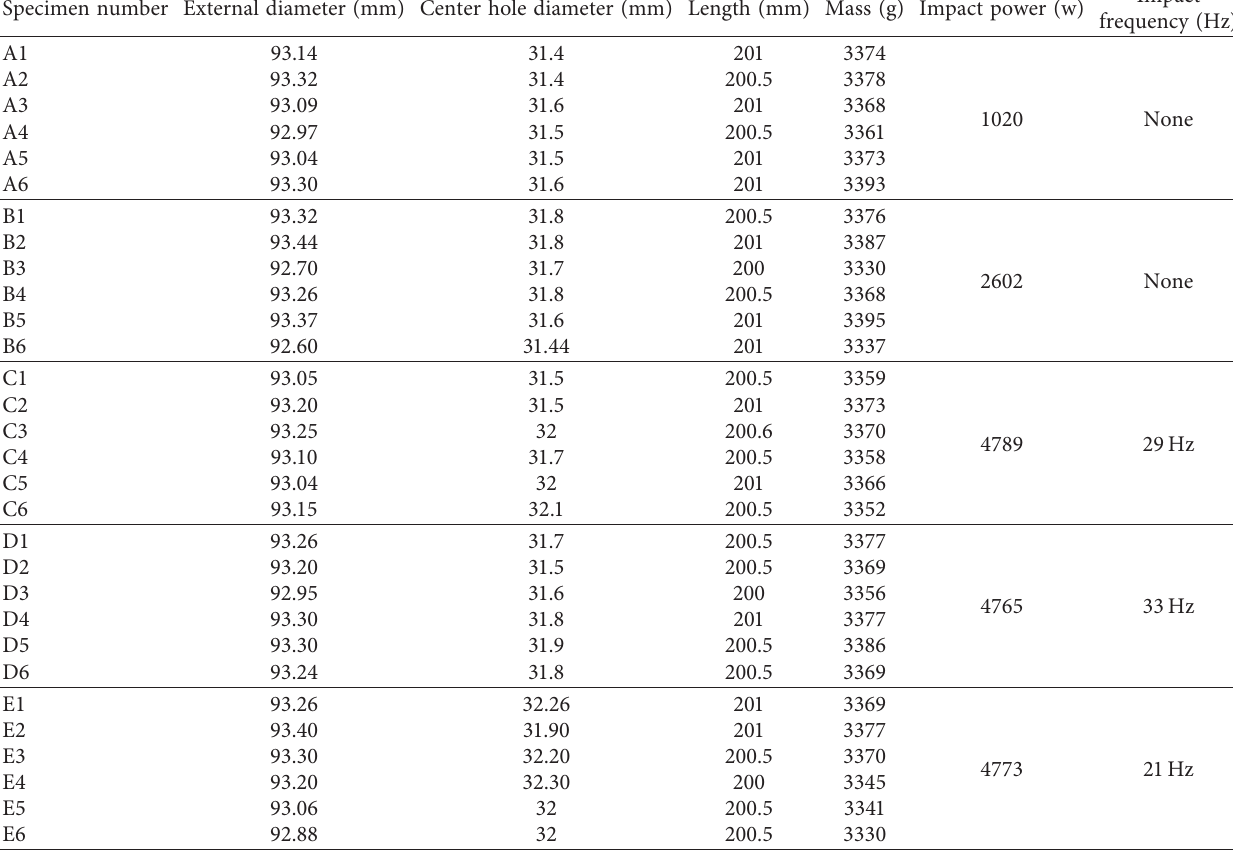
Table 4: Physical parameters and impact drilling parameters of granite specimens.